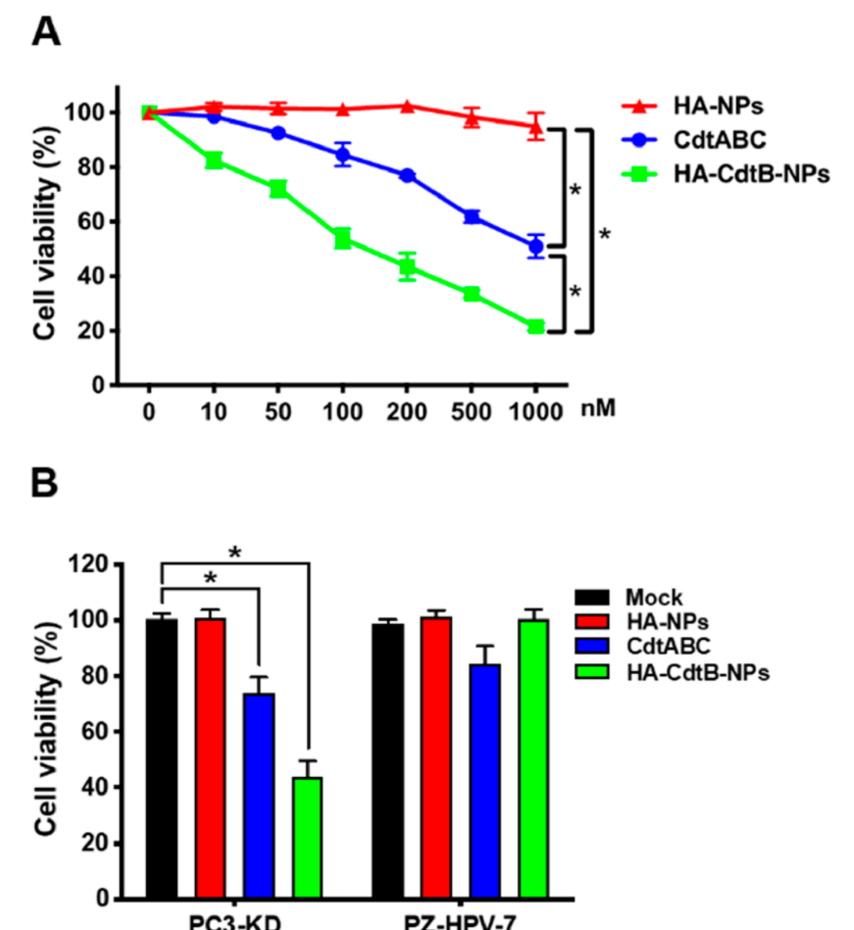
Figure 2. HA-CdtB-NPs inhibit PCa cell proliferation. ( A ) PC3-KD cells were treated with HA-NPs, CDT holotoxin, or HA-CdtB-NPs at the indicated concentrations (0–1000 nM) for 48 h. ( B ) PZ-HPV-7 and PC3-KD cells were treated with HA-NPs, CDT holotoxin, or HA-CdtB-NPs at the concentration of 100 nM for 48 h. Cell viability was assessed using MTT assay. Statistical significance was evaluated using one-way ANOVA with post hoc test (* p <